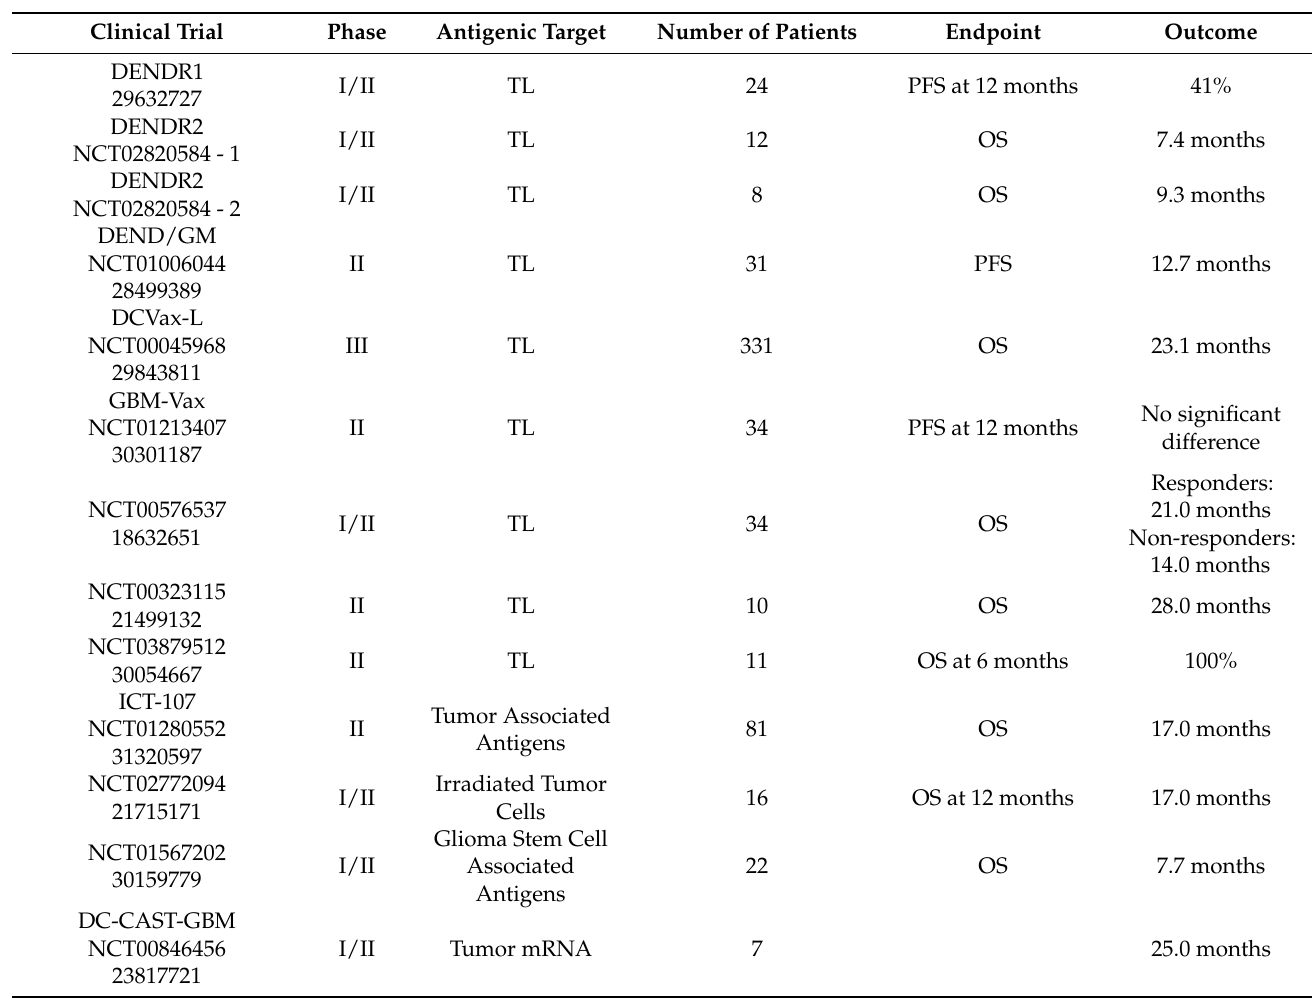
Table 2. Clinical glioblastoma dendritic cell vaccine trials. Tumor Lysate (TL); Progression Free Survival (PFS); Overall Survival